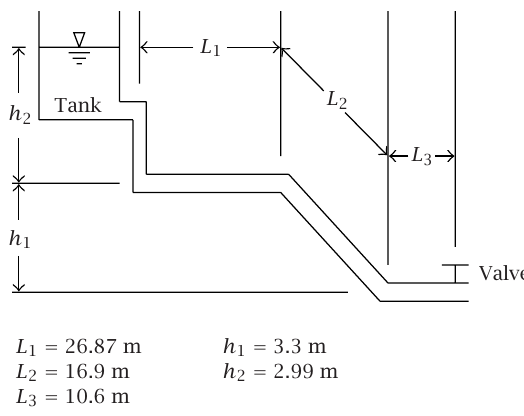
Figure 2.1 . Outline of the experimental